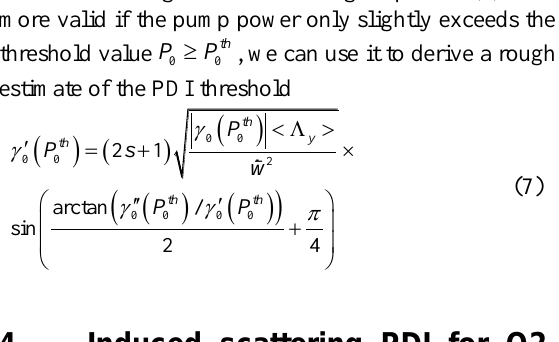
Fig. 4. Dependence of the power threshold on the ripple amplitude. The other parameters are the same as in figure 2.